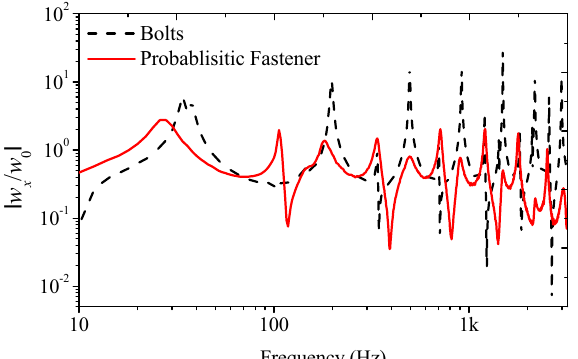
Figure 10. Vibration response of beam structure assembled with different fasteners – Probabilistic faster and